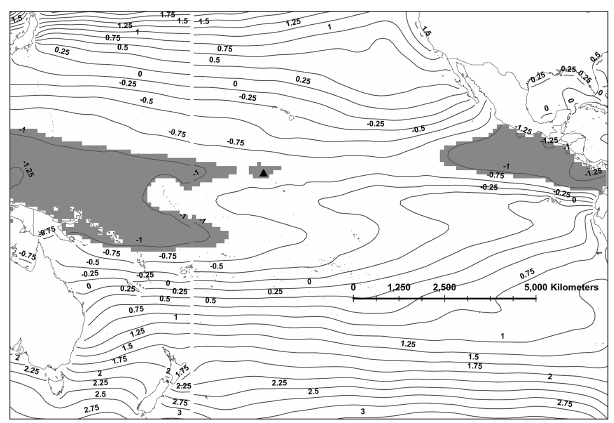
Figure 2. Adjusted oxygen isoscape (shaded in gray). PANWR is depicted by the black triangle. Solid lines are contours of predicted oxygen isotope ratios in barnacle calcite ( δ 18 O c )